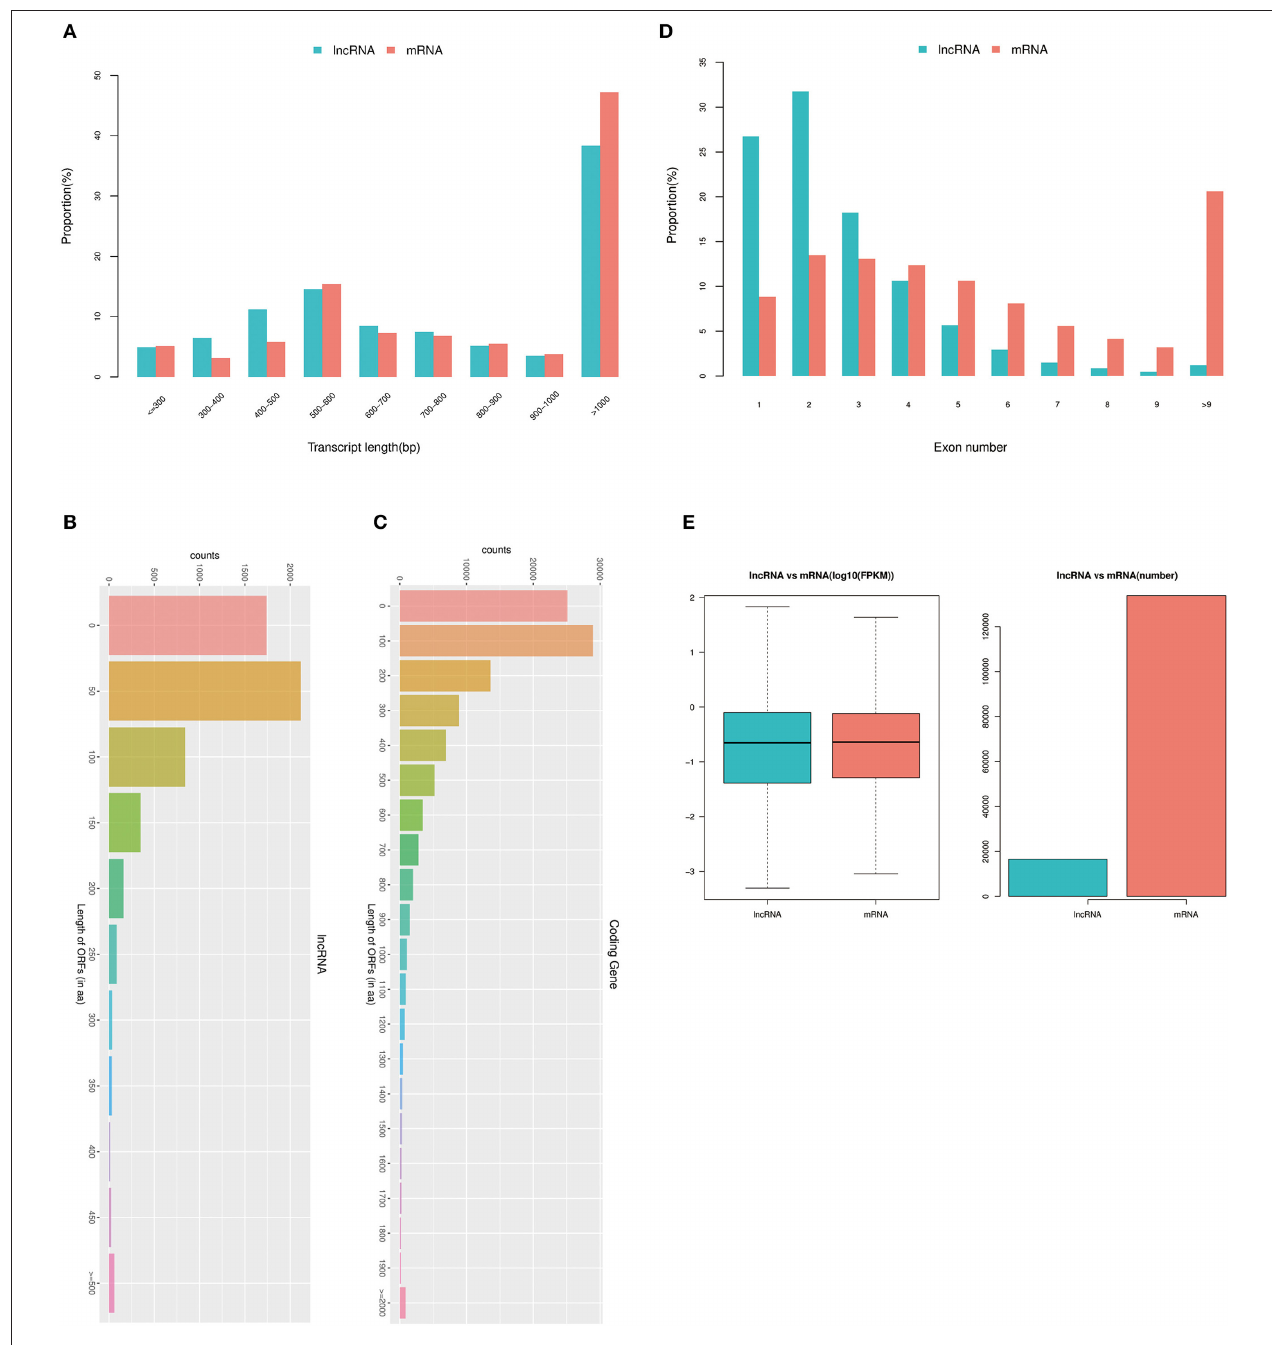
FIGURE 4 | Analysis of the structural characteristics of differentially expressed lncRNAs and mRNAs. (A) lncRNA and mRNA length statistics and comparisons; the x-axis represents the transcript length, and the y-axis represents the proportion. (B) Distribution of the ORF lengths of lncRNAs. (C) Distribution of the ORF lengths of mRNAs. (D) Statistics of lncRNA and mRNA exons. The x-axis represents the exon number of the lncRNA and mRNA, and the y-axis represents the proportion. (E) lncRNA and mRNA expression levels were statistically analyzed from two levels of log10 (FPKM) and